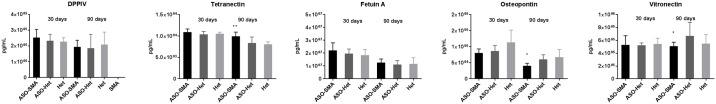
Longitudinal Measures of SMN-corrected biomarkers.DPPIV and fetuin A showed no statistically significant change compared to ASO-Het and Het mice at either P30 or P90. The other 3 analytes, tetranectin, osteopontin, and vitronectin, showed no change at P30 but were all altered at P90. * <0.05, ** <0.01.